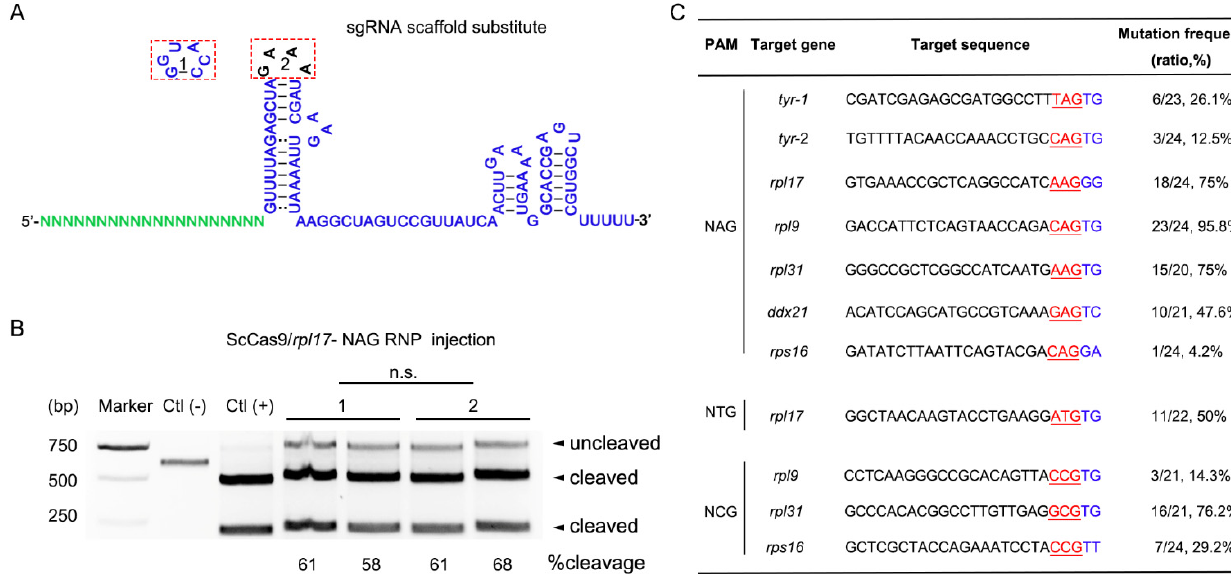
Figure 2. Genome editing in zebrafish using ScCas9. ( A ), Stem-loop differences between the ScCas9 original sgRNA tetraloop (1) and SpCas9 sgRNA tetraloop (2). ( B ), T7E1 assay of ScCas9/ rpl17 -NAG RNP-induced indel mutations. BsrBI - digested fragments of the purified PCR products were used as Ctl (+) and the undigested ones as Ctl ( − ). ( C ), Mutation frequency of ScCas9 at NNG PAM sites in zebrafish. The PAM is marked in red and underlined, and the downstream sequence of the PAM is marked in blue.